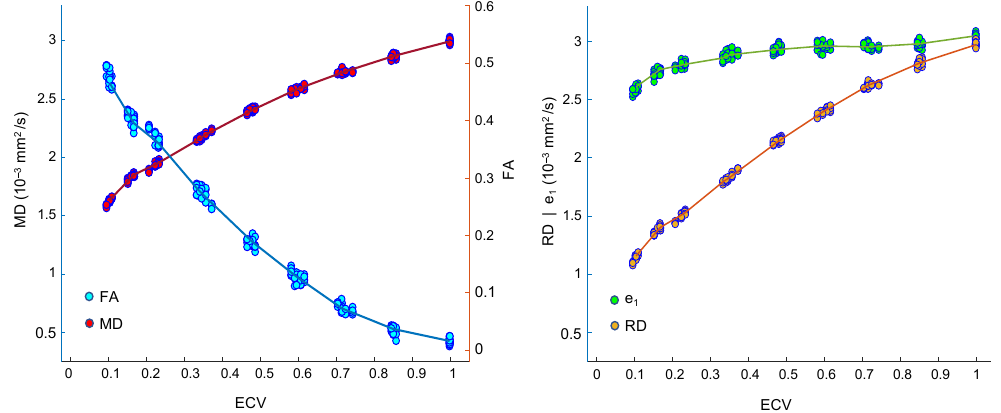
Figure 6. MD, FA, e 1 , and RD as a function of simulated ECV for 45 cellular structures and 5 diffusion distributions (225 cases in total). These results are obtained from diffusion simulations with 20,000 water molecules and a timestep ∆ t = 10 µ s. Cellular structures with similar ECV ( ± 0.05) are clustered together and median values of each cluster are connected to better visualize the overall trend of MD, FA, e 1 , and RD with increasing ECV.